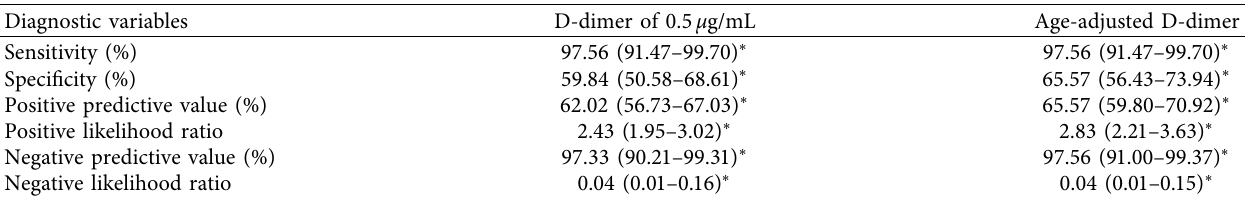
Figure 2: Receiver operating characteristic curve of D-dimer for the detection of acute aortic syndrome. Table 3: Comparison of diagnostic accuracy between D-dimer cutoff of 0.5 μ g/mL and age-adjusted D-dimer for ruling out acute aortic